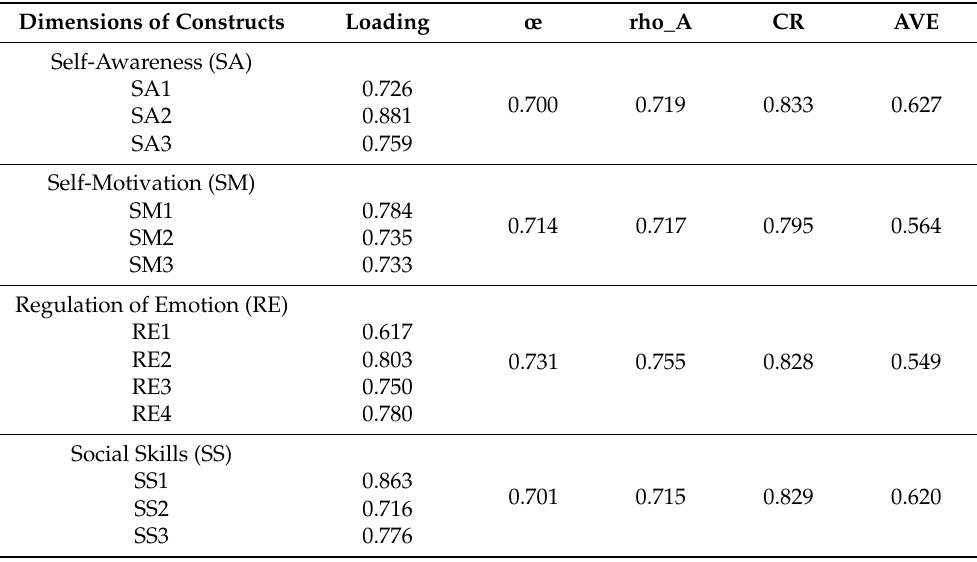
Table 1. Reliability and convergent